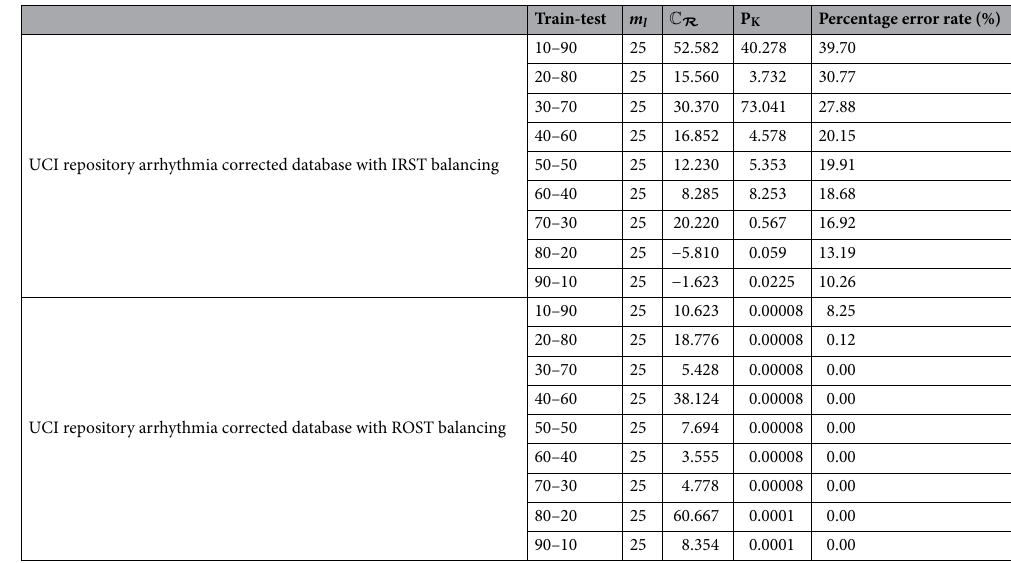
Table 8. Percentage error rate with values of m l , C R and P K obtained using proposed approach on UCI repository arrhythmia corrected